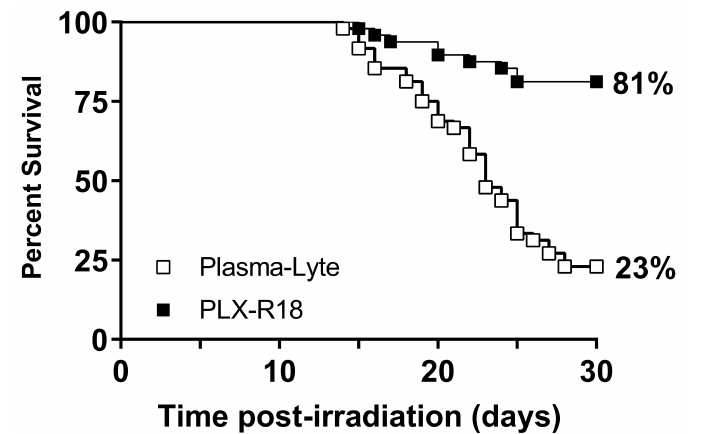
Figure 1. Survival of C57BL/6 male mice following total-body irradiation with 8 Gy at an estimated rate of 0.6 Gy/min and IM administration of two doses of PLX-R18 (2 million cells/dose) on 1 day prior to and 3 days post-TBI ( (cid:4) ) or PlasmaLyte as vehicle ( (cid:3)